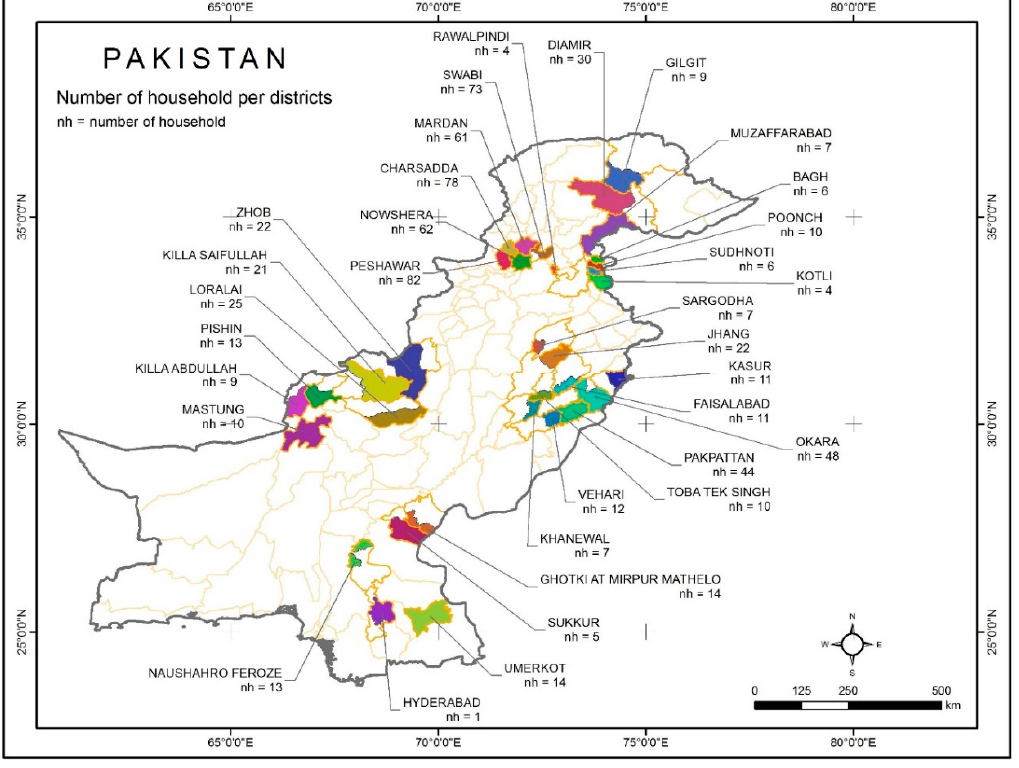
Figure 1. Description of the sample.